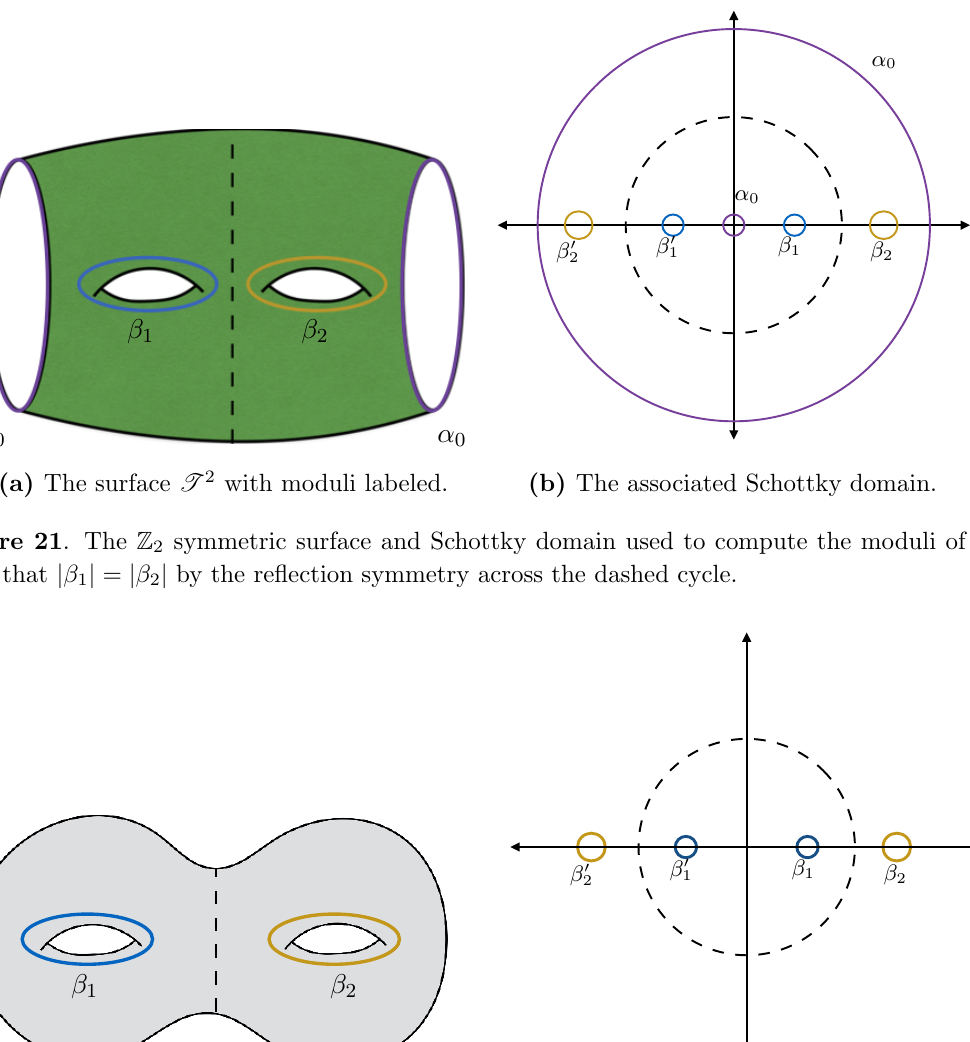
Figure 22 . The Z 2 symmetric surface and Schottky domain used to compute handlebody represented by the Schottky domain is a pure AdS